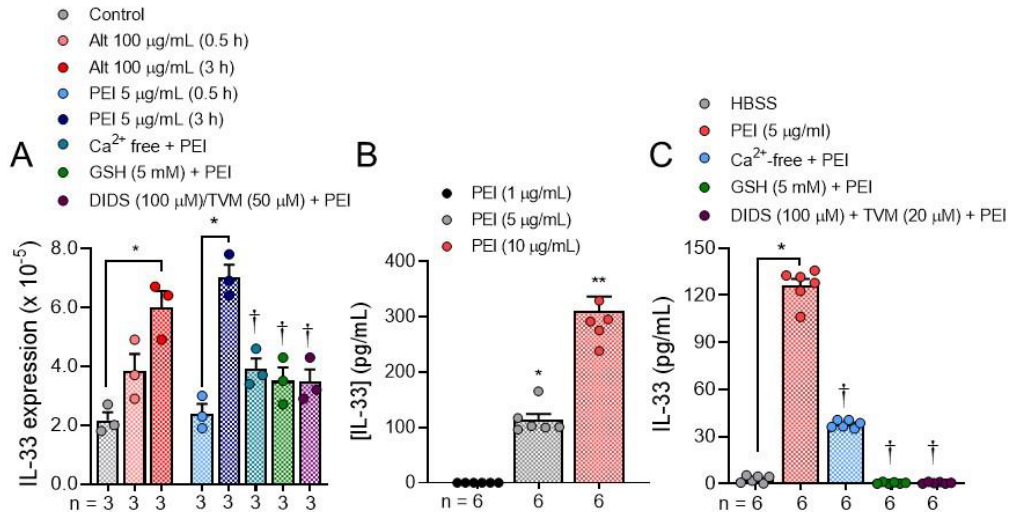
Figure 5. PEI stimulates IL-33 mRNA expression and secretion. ( A ). Exposure of immortalized hBE cells transfected with full length human IL-33 gene (GET-33 cells) to Alternaria (Alt) 100 µ g/mL for 0.5 and 3 h resulted in a significant (* p < 0.0001) increase in IL-33 mRNA expression after 3 h. A similar increase was observed following exposure to PEI (5 µ g/mL) at 3 h. Pretreatment with GSH (5 mM) or removal of extracellular [Ca 2+ ] (Ca 2+ -free conditions) or inhibition of ATP release with both DIDS (100 µ M) and TVM (20 µ M) significantly blocked the PEI-induced increase in IL-33 mRNA expression ( † p < 0.0008). ( B ). Treatment of GET-33 cells with PEI for 1 h produced a concentration-dependent increase in IL-33 secretion (* p < 0.0002; ** p < 0.0001). ( C ). PEI (5 µ g/mL) induced IL-33 secretion (* p < 0.0001) was inhibited ( † p < 0.0001) under; (i) Ca 2+ -free conditions, (ii) when oxidative stress was blocked by pretreatment with GSH (5 mM) and (iii) when ATP release was completely inhibited using DIDS (100 µ M) + TVM (20 µ M). Multiple comparisons were made using a one-way ANOVA followed by Tukey’s posttest for each figure.